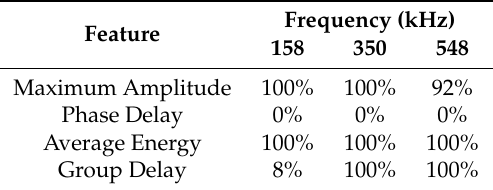
Table 3. Ratios of selection of the features without echo